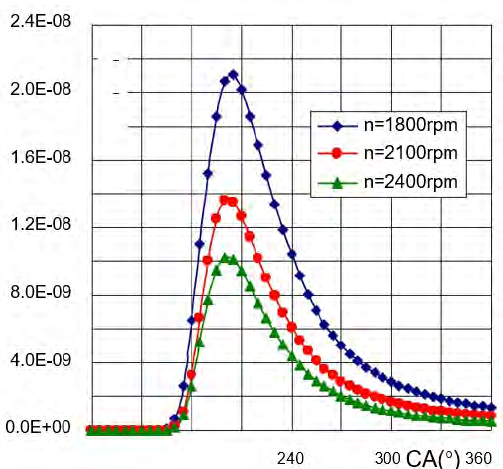
Figure 14. Soot concentration vs crank angle with different engine speeds (D20, ϕ